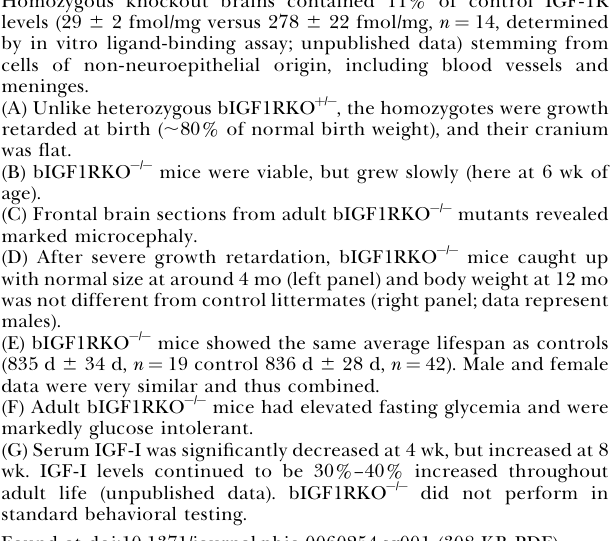
Figure S1. Phenotype of Mice with Homozygous IGF-1R Knockout in the CNS (bIGF1RKO (cid:2) / (cid:2)